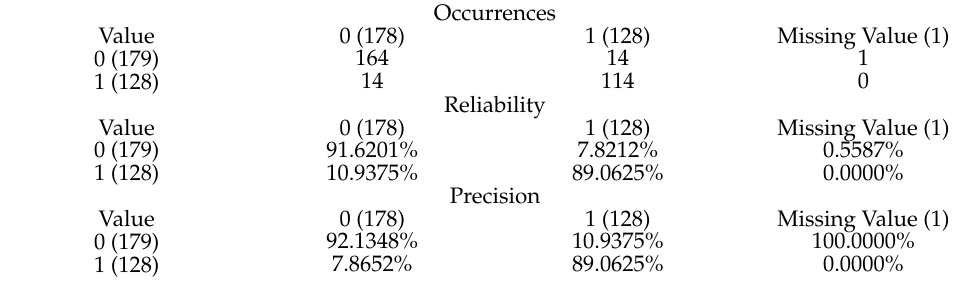
Table 6. Elements show the correctly and incorrectly predicted test data for each class of BN + CNN